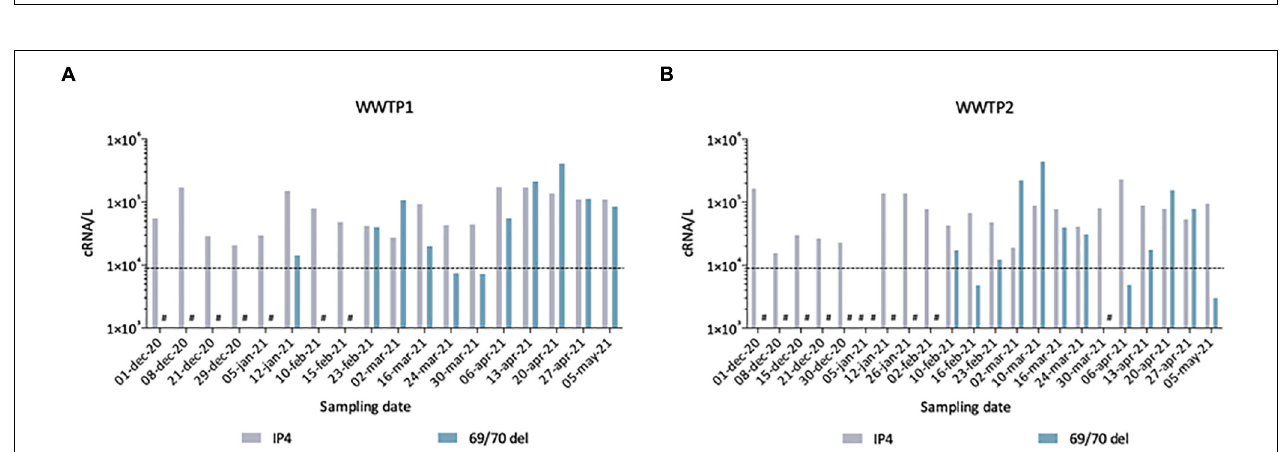
FIGURE 7 | Quantification of total SARS-CoV-2 (IP4) and Alpha VOC (69/70 del) estimated by qRT-PCR in raw wastewater samples from WWTP1 (A) and WWTP2 (B) . Some samples gave signals below the theoretical limit of detection (LOD) of 9 × 10 3 cRNA/L (dotted line), others gave no signal/no Ct (#).